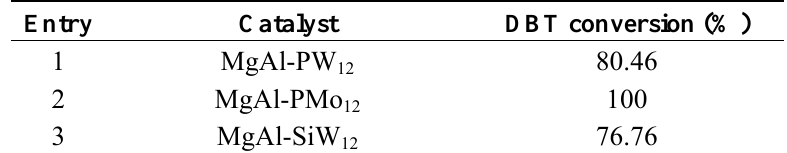
Table 2. Investigation of desulfurization catalyzed by different